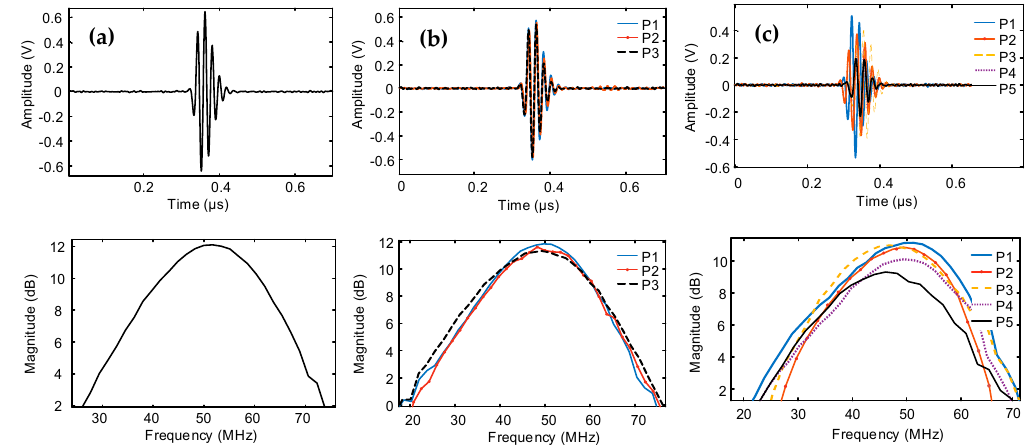
Figure 8. Measured time domain (top row), pulse-echo response (bottom row) of ( a ) single-focal point transducer T 1 , ( b ) three-focal points MFP transducer T 2 , and ( c ) five-focal points MFP transducer T 3.